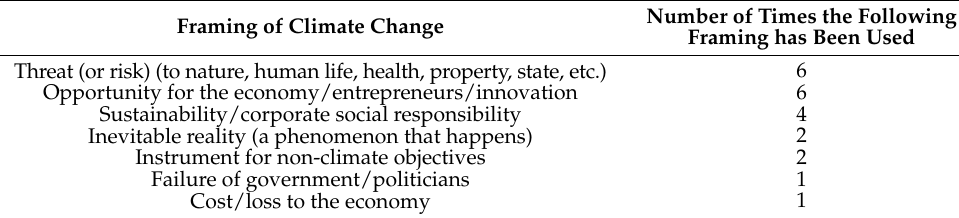
Table 10. Saeima election programmes’ framing of climate change. Framing of Climate